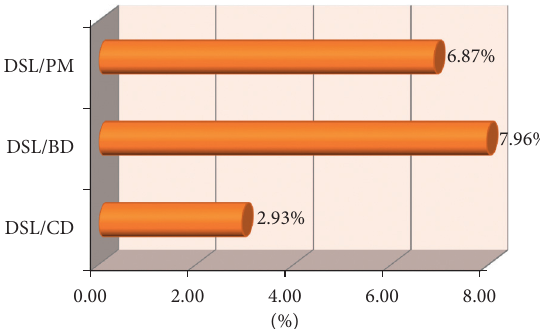
Figure 10: Fixed carbon content of the briquettes with different binders.